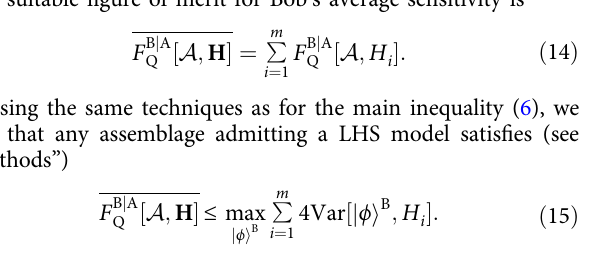
Fig. 2 EPR-assisted metrology with twin Fock states. a We consider a twin Fock state with N = 200 particles, that is split into two parts with N = N = N /2, here represented by the Wigner function on the Bloch A B sphere. b The reduced state on either side is a mixture of Dicke states, resulting from tracing out the other half of the system. c The two subsystems show perfect correlations for both measurement settings J x and J z : When Alice measures J A z ( J A x ) and obtains the result k A , she steers Bob ’ s system into an eigenstate of J B z ( J B x ) with eigenvalue N /2 − k A . This can be used for assisted quantum metrology, and to reveal an EPR ½ ρ B ; J B (cid:2) when Alice paradox. In the plot we show Bob ’ s sensitivity F z Q k A j J A x obtains the result k A from measuring J A x (blue line). Alice ’ s results are all j J A Þ ¼ 2 = ð N þ 2 Þ . Bob ’ s average sensitivity equally probable with p ð k x A F B j A ½j SD i ; J B (cid:2) coincides with the variance for the reduced state N ; N = 2 z Q 4Var ½ ρ B ; J B z (cid:2) (yellow line), indicating that the measurement is optimal (Supplementary Note